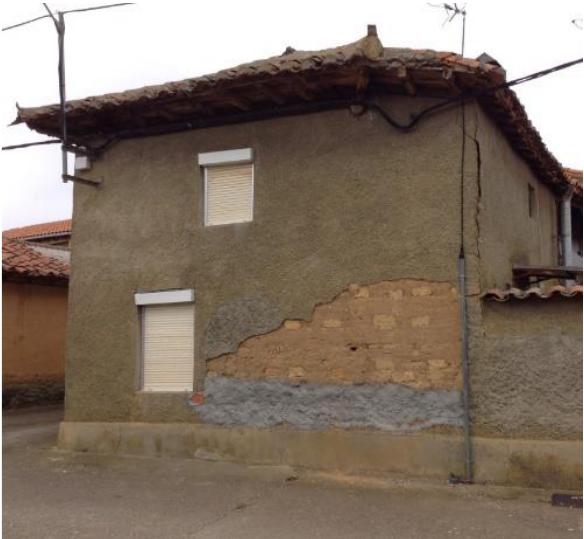
Figure 4. Transformation of an earthen house (Molezuela de la Carballeda,